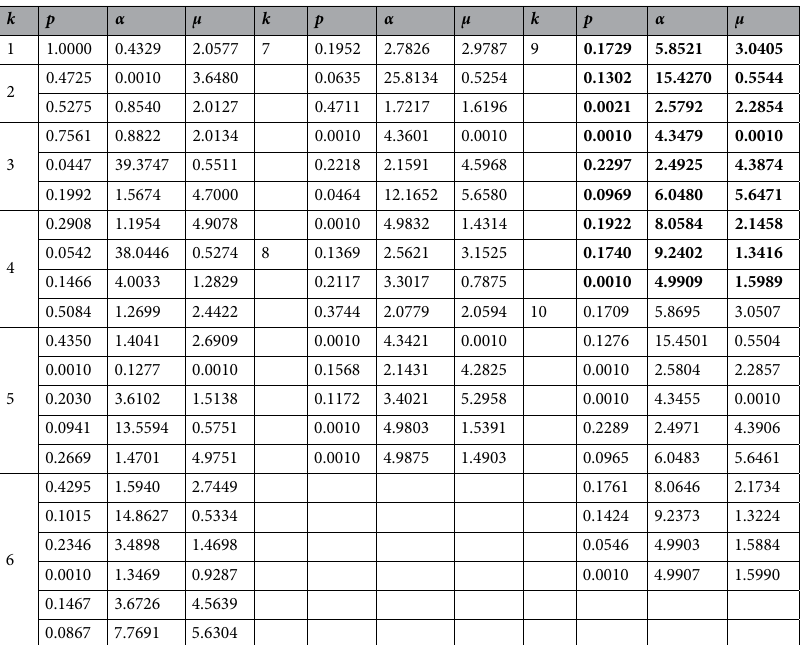
Table 4. Parameter estimation results for mixture voM wind direction model. The complexity of wind direction model increases with the increasing number of components for mixture model. For example, for a wind direction mixture model with 9-component voM distributions, a total of 26 unknown parameters need to be estimated. The results of the best model are in